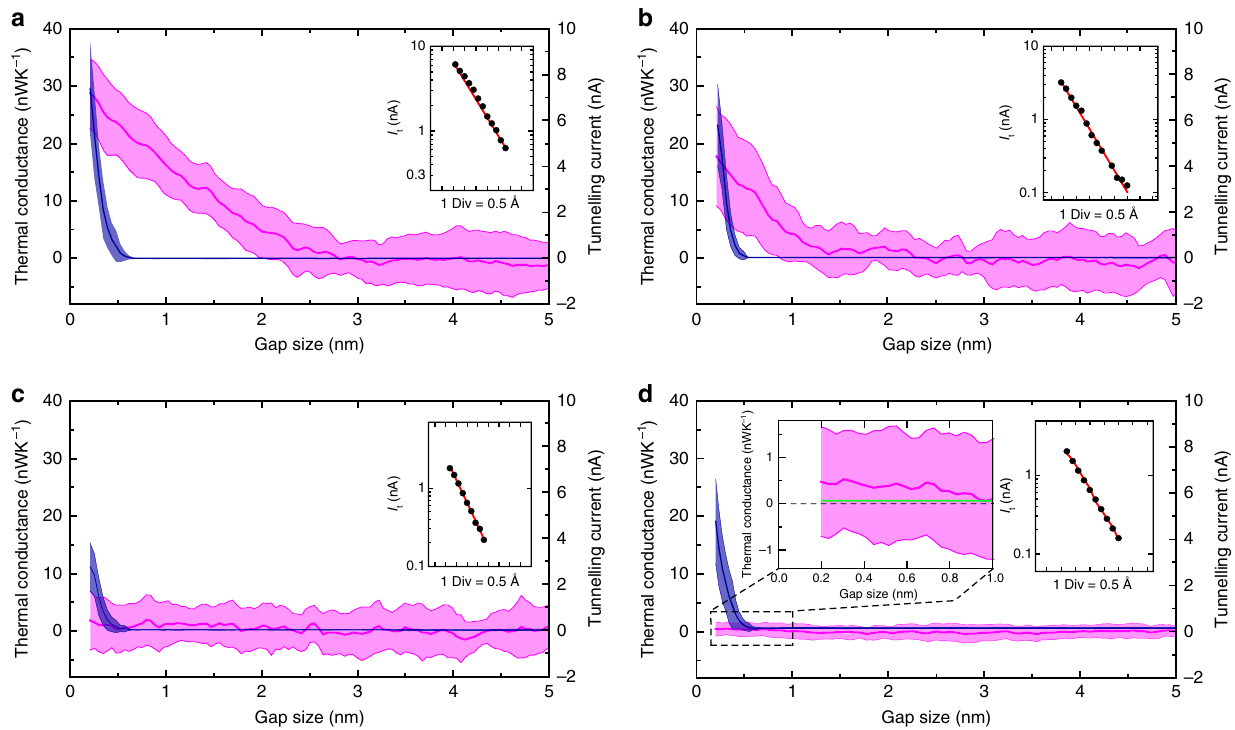
Figure 2 | Measured gap size-dependent thermal conductance and tunnelling current. Each thermal conductance (pink) and tunnelling current (blue) curve is averaged over 15 repeated measurements. The shaded region represents the s.d. The first three panels show representative experimental results from ( a ) organic solvent-cleaned, ( b ) oxygen plasma-cleaned and ( c ) repeated oxygen plasma-cleaned probes. The gold sample is heated while the probe is maintained at a lower temperature to create a temperature difference D T ¼ 40K. ( d ) The measurement results obtained in experiments where a large temperature differential ( D T ) of 130K was applied. The thermal conductance data in the subnanometre region is shown on an expanded scale in the inset to facilitate visualization. The green line in the inset panel corresponds to the near-field radiative thermal conductance calculated from fluctuational electrodynamics. Further, the measured tunnelling currents versus displacement are shown in insets for each of the plots and were used in the analysis of the apparent tunnelling barrier height j ap . The estimated values of j ap are 1.1, 1.6, 1.7 and 1.9eV for a – d ,